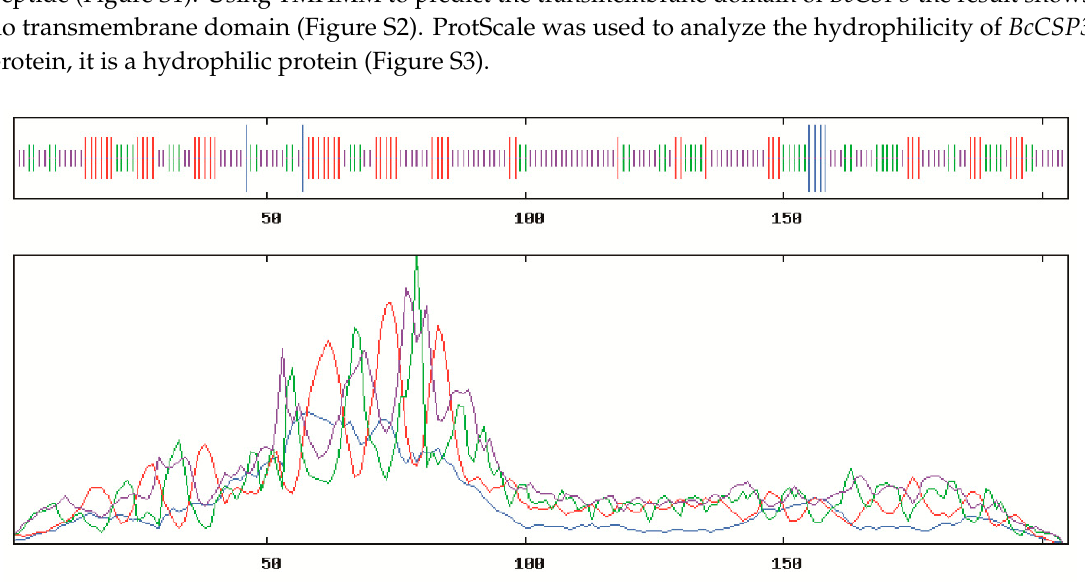
Figure 3. Tertiary structure prediction of the BcCSP3 protein. Random coil, extended strand and beta turn make up most of the main body.